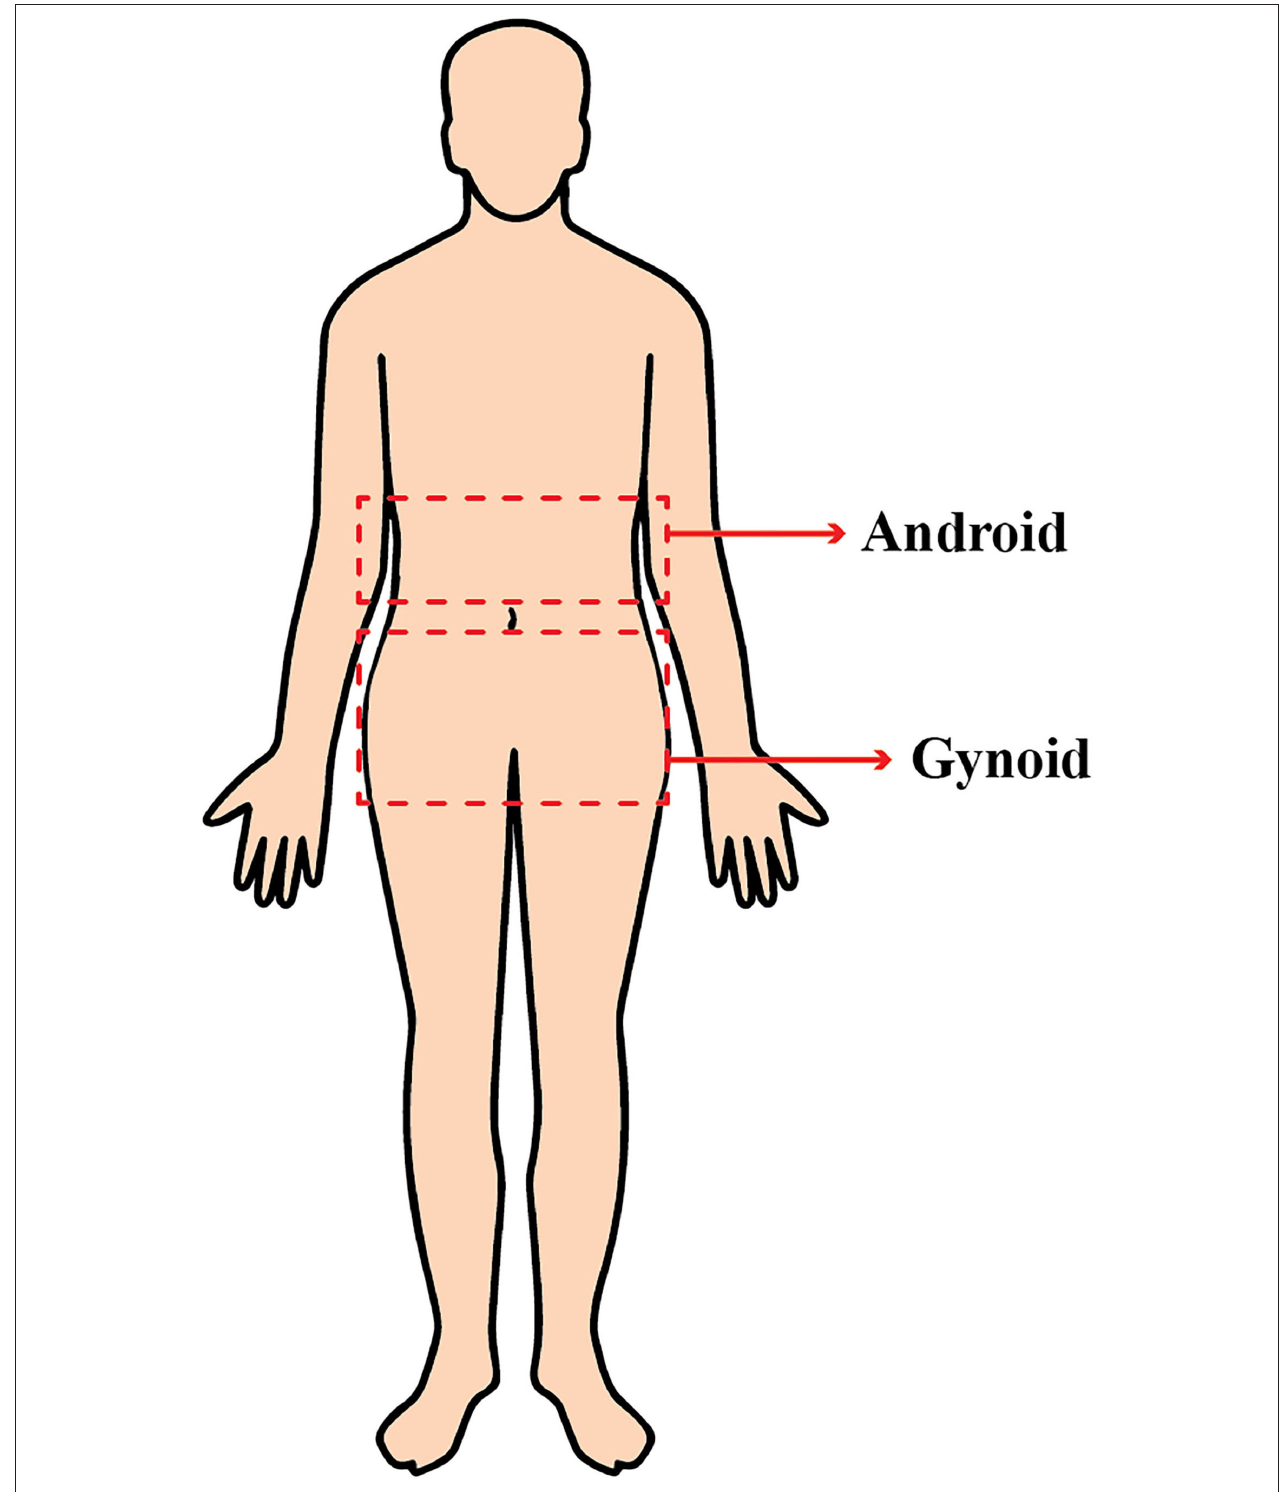
FIGURE 1 | Android and gynoid body fat